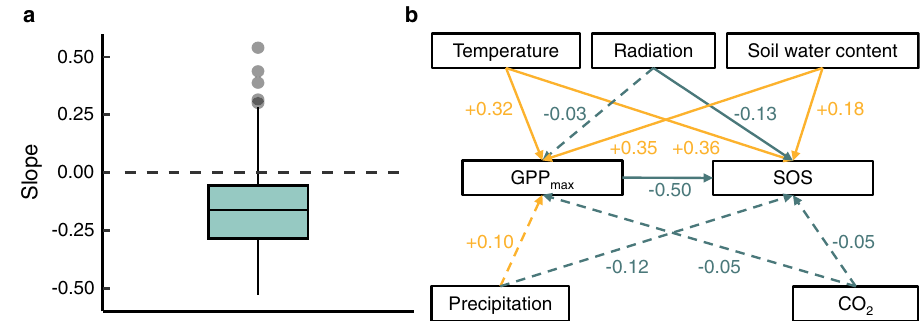
Fig. 4 Effects of GPP max and climate variables on start of season (SOS) based upon FLUXNET data. a Regression coef fi cients (Slope) of normalized anomalies of SOS in current year in response to normalized anomalies of GPP max in previous growing season ( N = 28). b Piecewise structural equation model (SEM) considering both GPP max and climate variables. The GPP max refers to the maximum daily gross primary productivity (GPP) in each year. In a , the black dash lines indicate when slope is equal to zero, the box spans from the fi rst to the third quartile, with intermediate values marked as the black line in the middle of the box, and the gray points represent the outliers whose values exceed 1.5 times the length of the box. In b , both climate factors (temperature, radiation, soil water content, precipitation, and CO 2 ) and GPP max were incorporated into the SEM to explore the direct (arrows from each climate factor directly point to the SOS) or indirect (arrows from each climate factor fi rstly directly point to GPP max then to the SOS) effects of climate factors on spring phenology, with green lines indicating a negative effect and orange lines indicating a positive effect. The solid lines represent signi fi cant relationships ( P < 0.05) between variables, while dashed lines represent no signi fi cant relationships between variables ( P > 0.05). The calculated P values based on two-sided test and other statistics were listed in Supplementary Table 4.